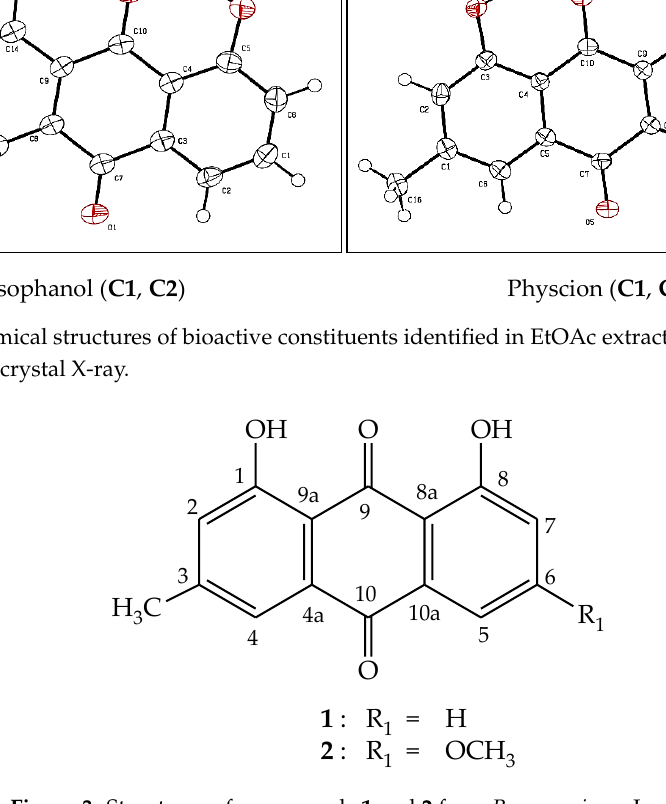
Figure 3. Structures of compounds 1 and 2 from Rumex crispus L. root.